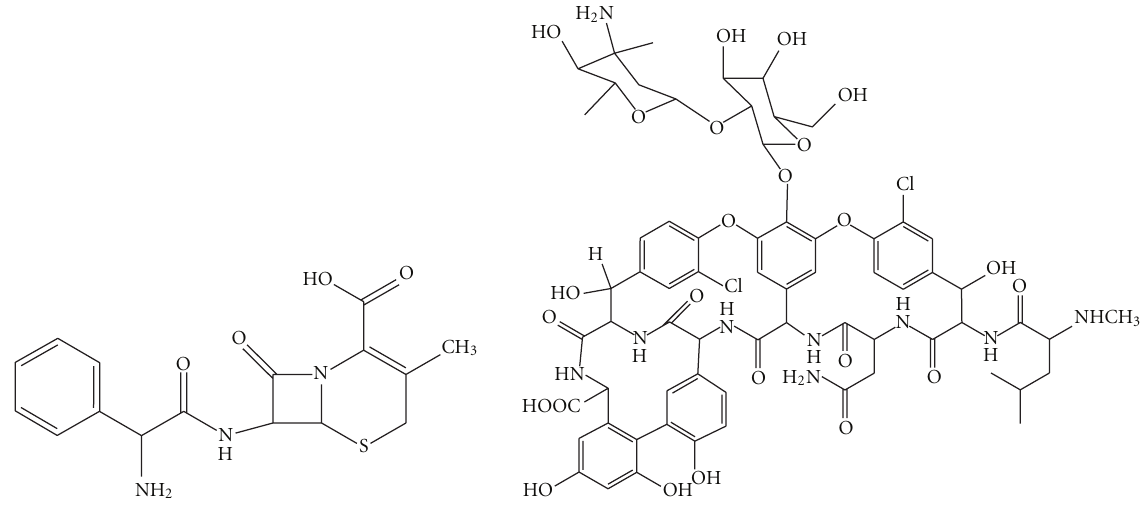
Figure 1: The structures of vancomycin and